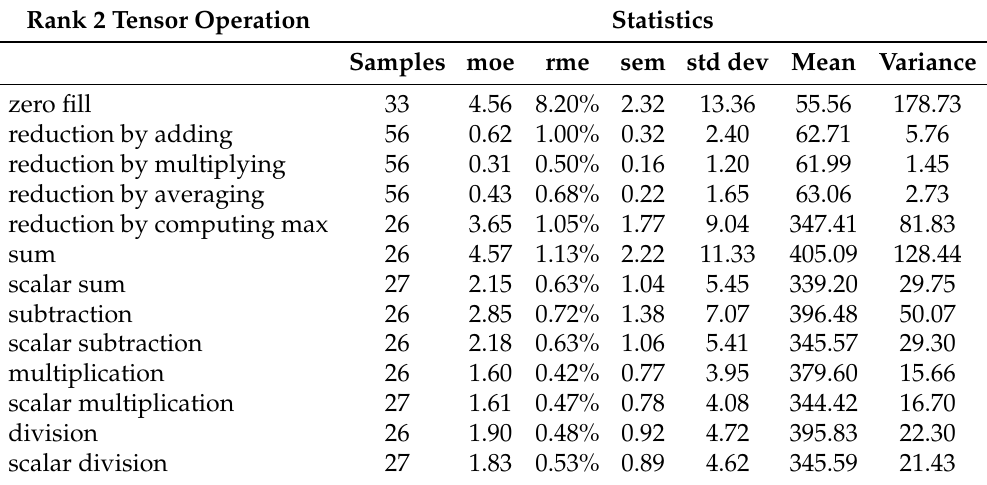
Table 22. Raspberry Pi IV benchmark statistics for rank 2 tensor operations with k = 128 (times in ms).